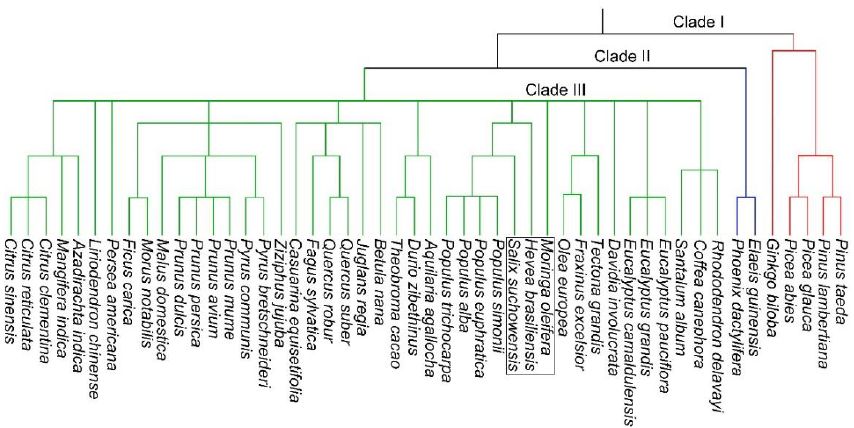
Figure 2. Phylogenetic tree of the 50 tree species with published genome sequences. The topology is based on the total molecular information available at the taxonomy browser of NCBI (https://www.ncbi.nlm.nih.gov/Taxonomy/CommonTree/wwwcmt.cgi; accessed on 20 February 2022).